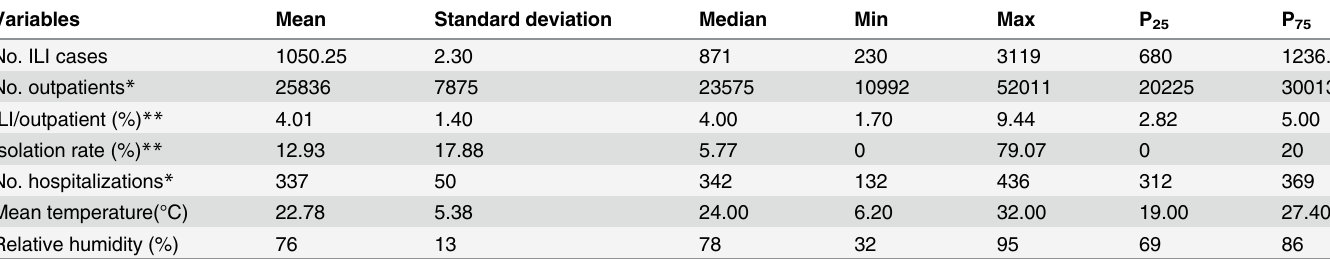
Table 2. Weekly statistical results of the main indicators in the time series Poisson generalized additive model # .